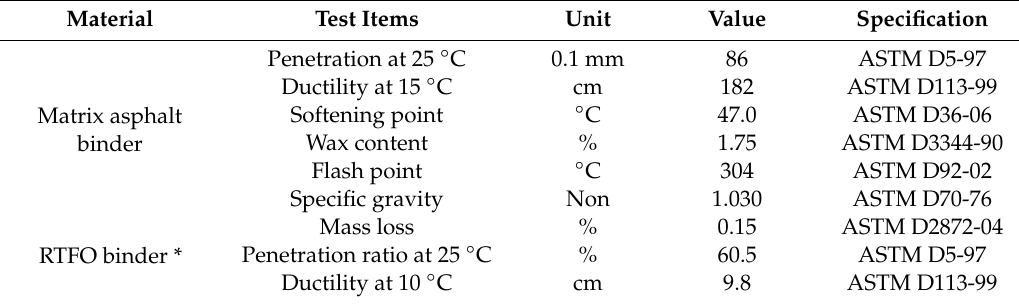
Table 1. Technical Properties of SK-90# Asphalt Binder.